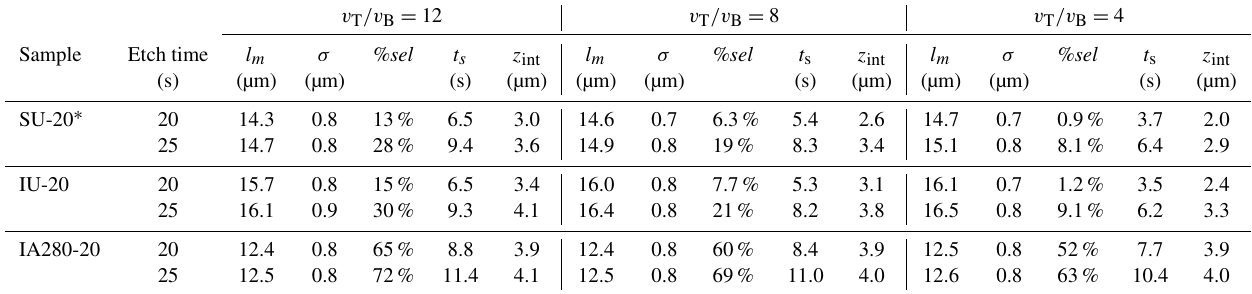
IA280-20 ∗ Model does not include Cf irradiation, making predictions different from Table